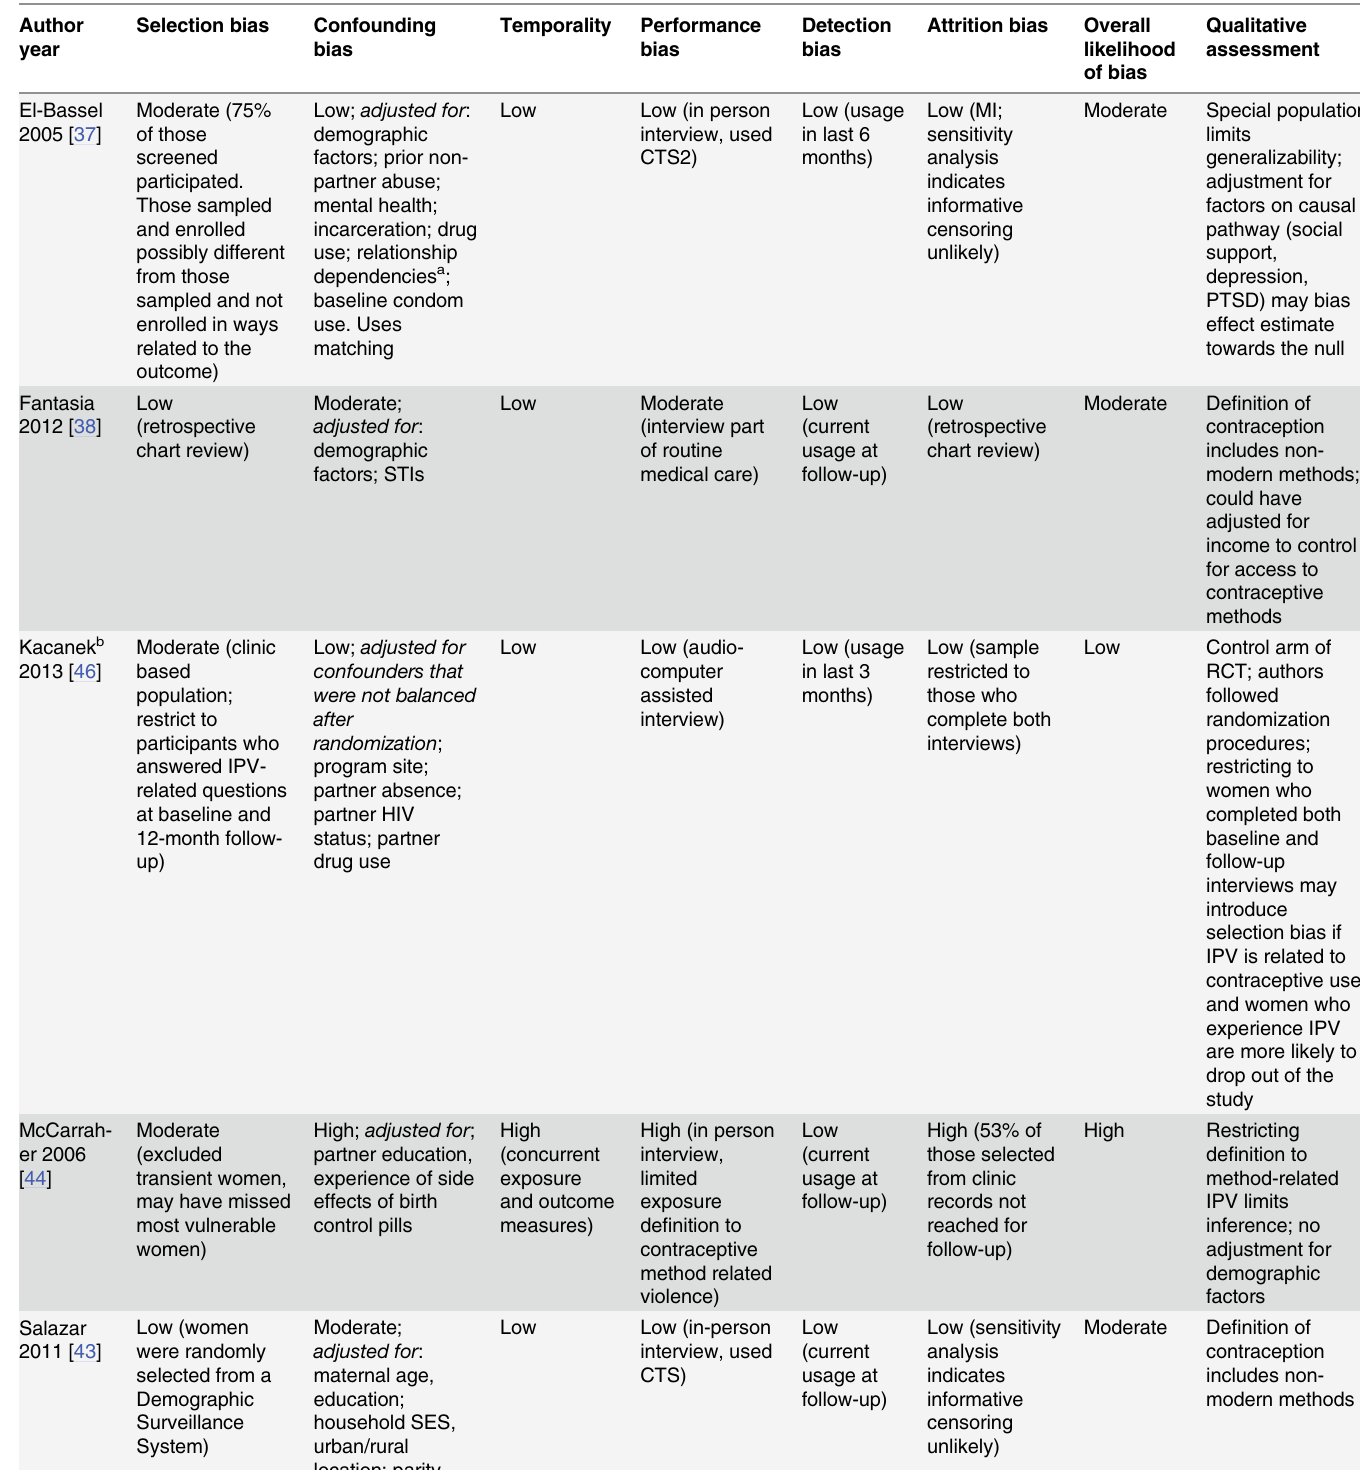
Table 2. Quality assessment of included case-control, RCT, and longitudinal